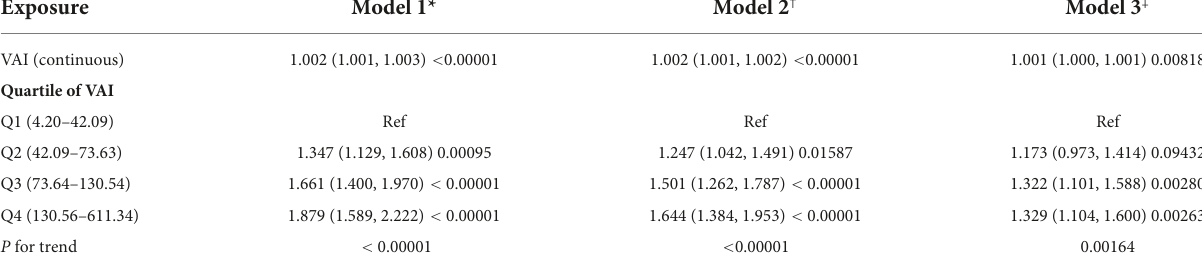
TABLE 2 Association of VAI with kidney